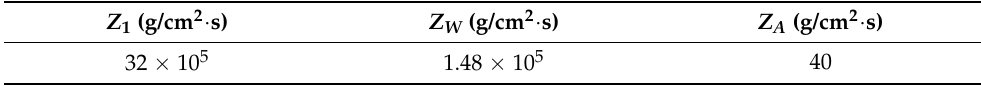
Table 1. Acoustic impedances of different